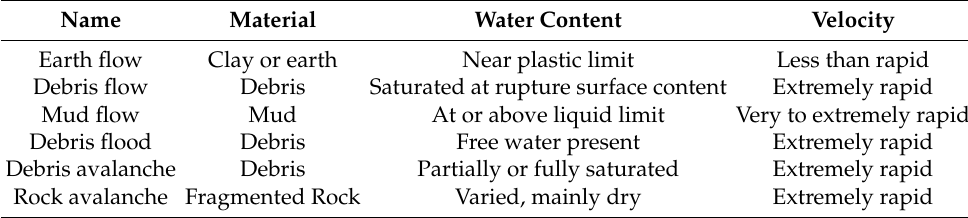
Table 1. Characteristics of several well-known flow types based on Hungr et al.